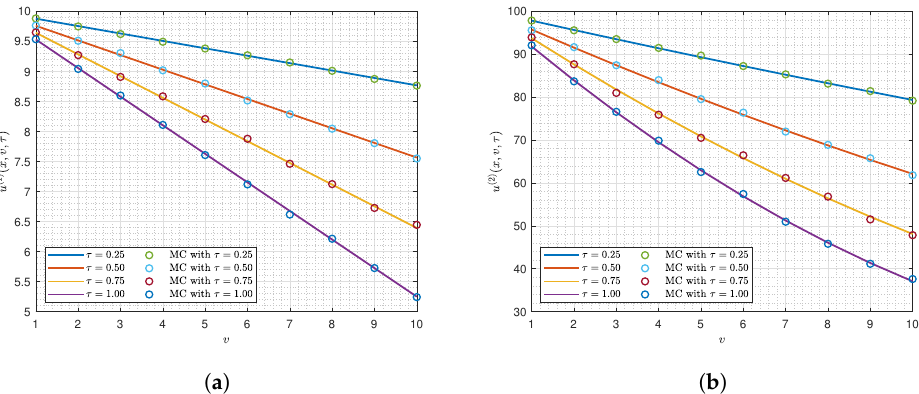
Figure 2. Validation tests of the first and second conditional moments for the initial values x = 10 and v = 1,2,3, . . . ,10 at different τ = 0.25,0.5,0.75,1. ( a ) The first conditional moment u ( 1 ) ( 10, v , τ ) . ( b ) The second conditional moment u ( 2 ) ( 10, v , τ )